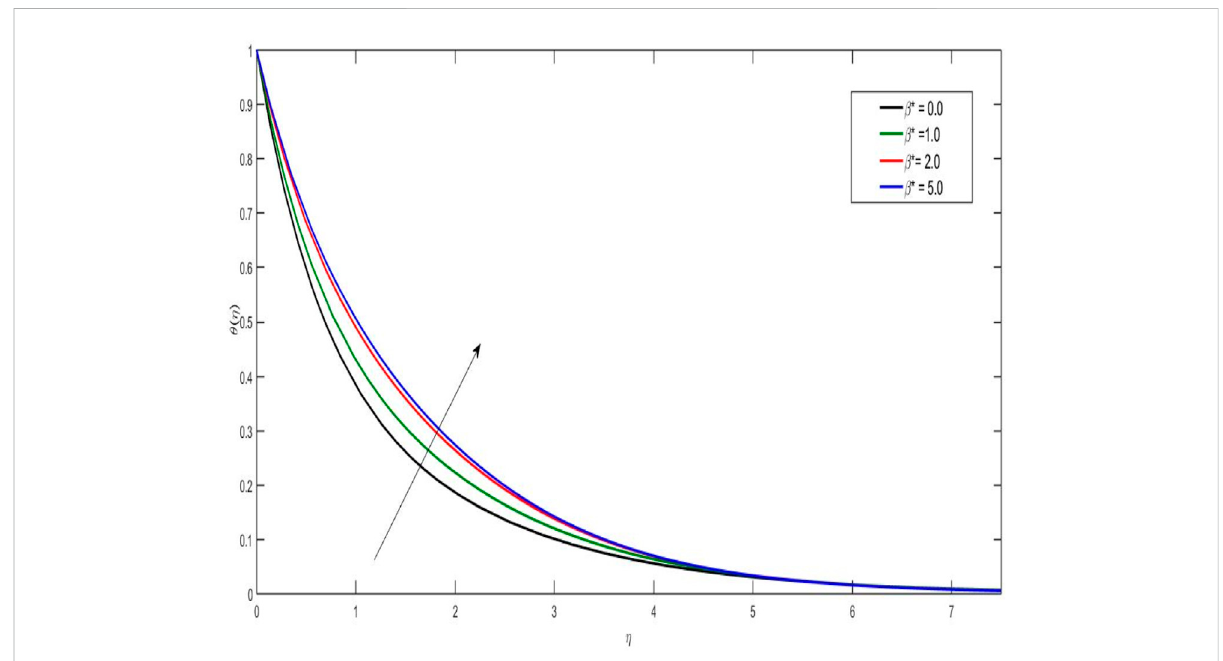
FIGURE 7 Temperature pro fi le as a function of changing heat generation.